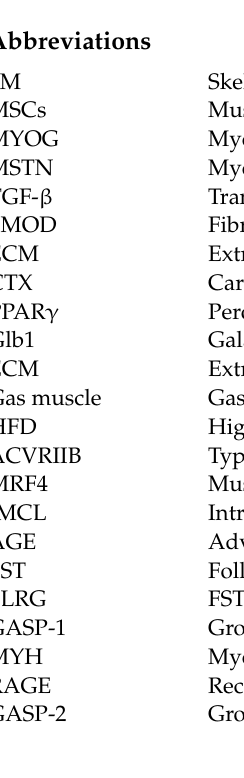
Figure S3: Protein expression between 16 and 26 weeks old muscles. Protein expression was deter- mined by Western blot and band intensities were measured by Image J, Figure S4. mRNA expressions in 0 and 2 days differentiated cells. C2C12 cells were cultured with differentiation media for 2 days; FMOD, MSTN, MYOG, CD36, Myosin heavy chain (MYH), Atrogin1, Glb1, RAGE, PPAR γ , p53, and FOXO3 mRNA expressions were analyzed by real-time RT-PCR. Means ± SD (n > 3). * p ≤ 0.05, ** p ≤ 0.001, *** p ≤ 0.0001. Figure S5: p53, Bax and FOXO3 genes expression in ceramide-treated cells. C2C12 cells were cultured with differentiation media supplemented with 50 uM ceramide for 2 days, and p53, Bax and FOXO3 mRNA expression were analyzed by real-time RT-PCR. Means